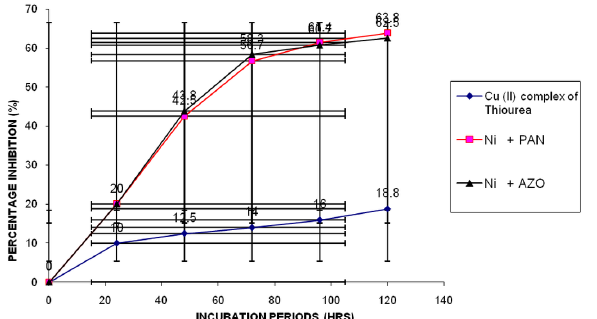
Fig. 4. Reduction of Mycelial growth of Collectotrichum capsici at 10 mg/ml concentration